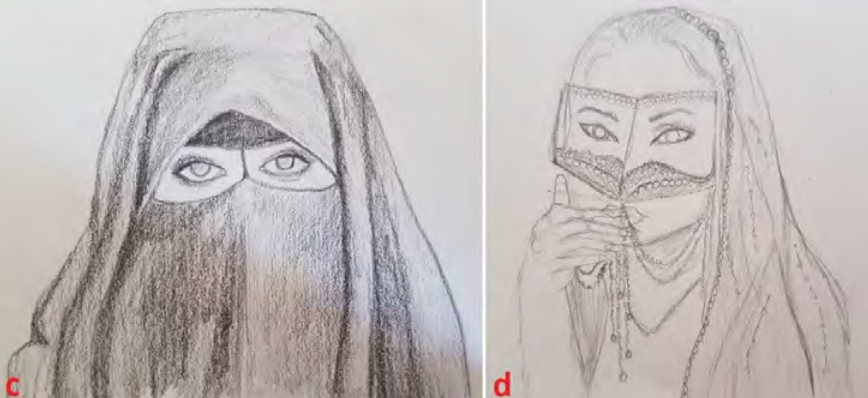
Figure 2. Omani modern Bedouinburqa worn by Dhofari women (c); Omani modern Saif Malik burqa face mask wornby women/girls as fashion, decoration (batoola) (b). Drawings by the Osman